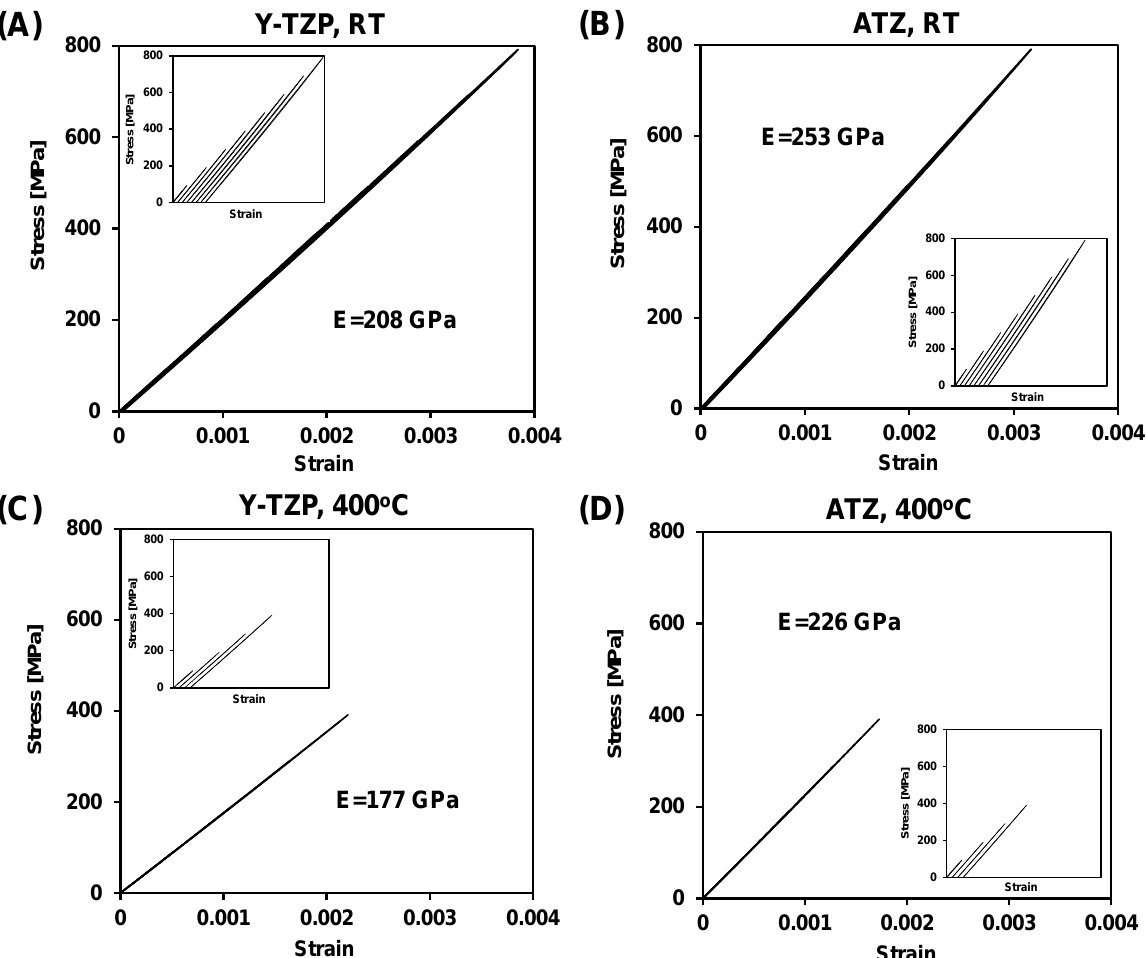
Figure 7. Cyclic stress-strain deformation plots of Y-TZP ( A , C ) and ATZ ( B , D ) ceramics measured at RT ( A , B ) and 400 °C ( C , D ).